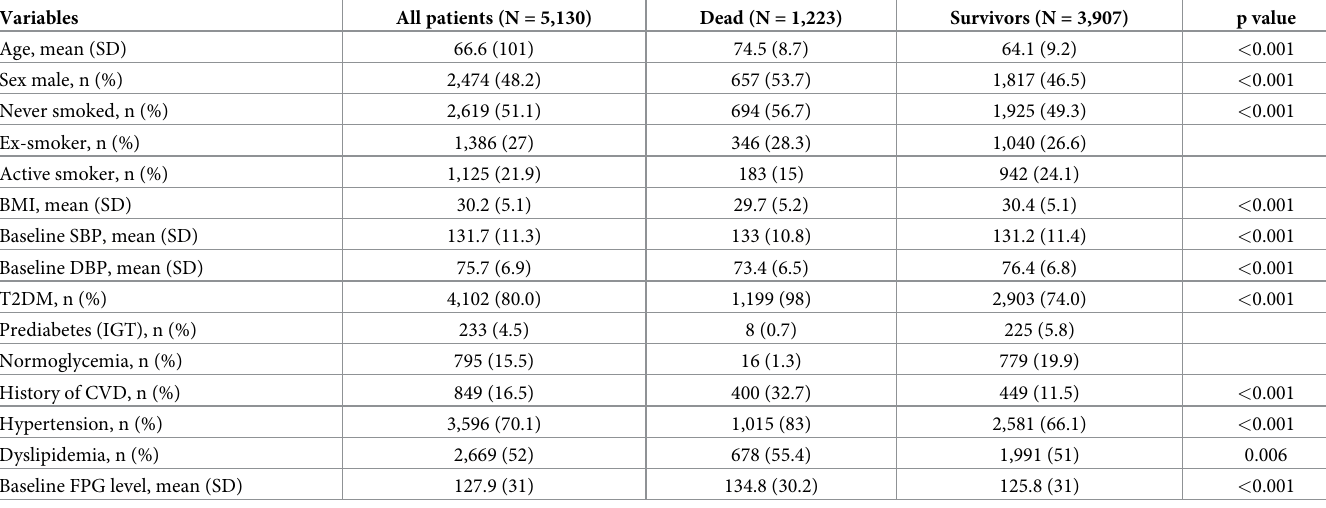
Table 1. Baseline socio-demographic, anthropometric, and clinical data of study participants overall and by survival status. Variables